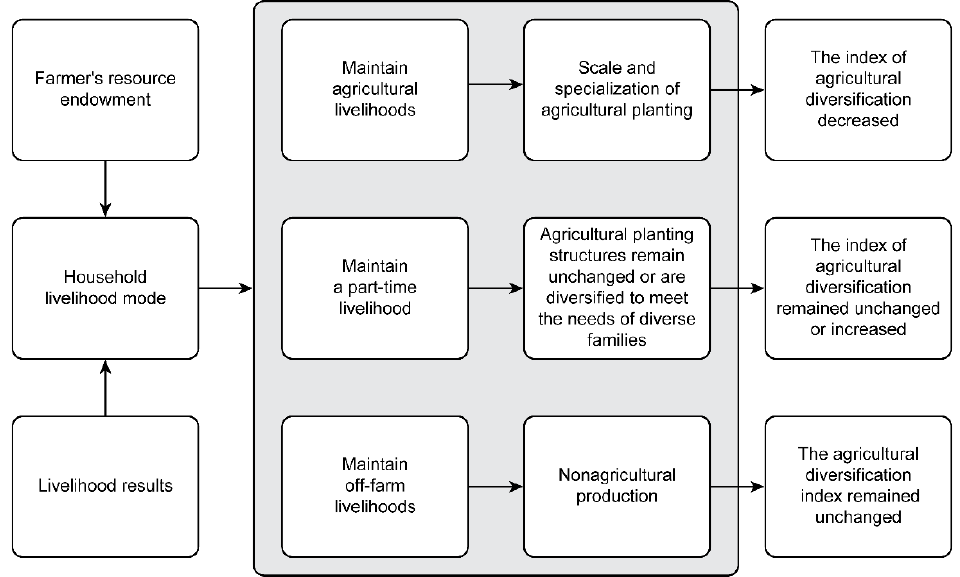
Figure 1. Impact of maintenance livelihood on agricultural diversification.